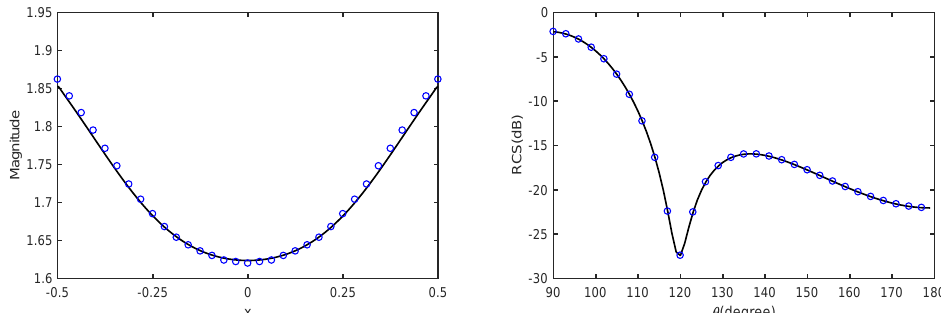
Figure 5. The magnitude of the aperture fields at normal incidence ( left ) and backscatter RCS ( right ) in TE